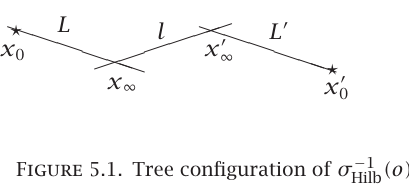
Figure 5.1 . Tree configuration of σ − 1